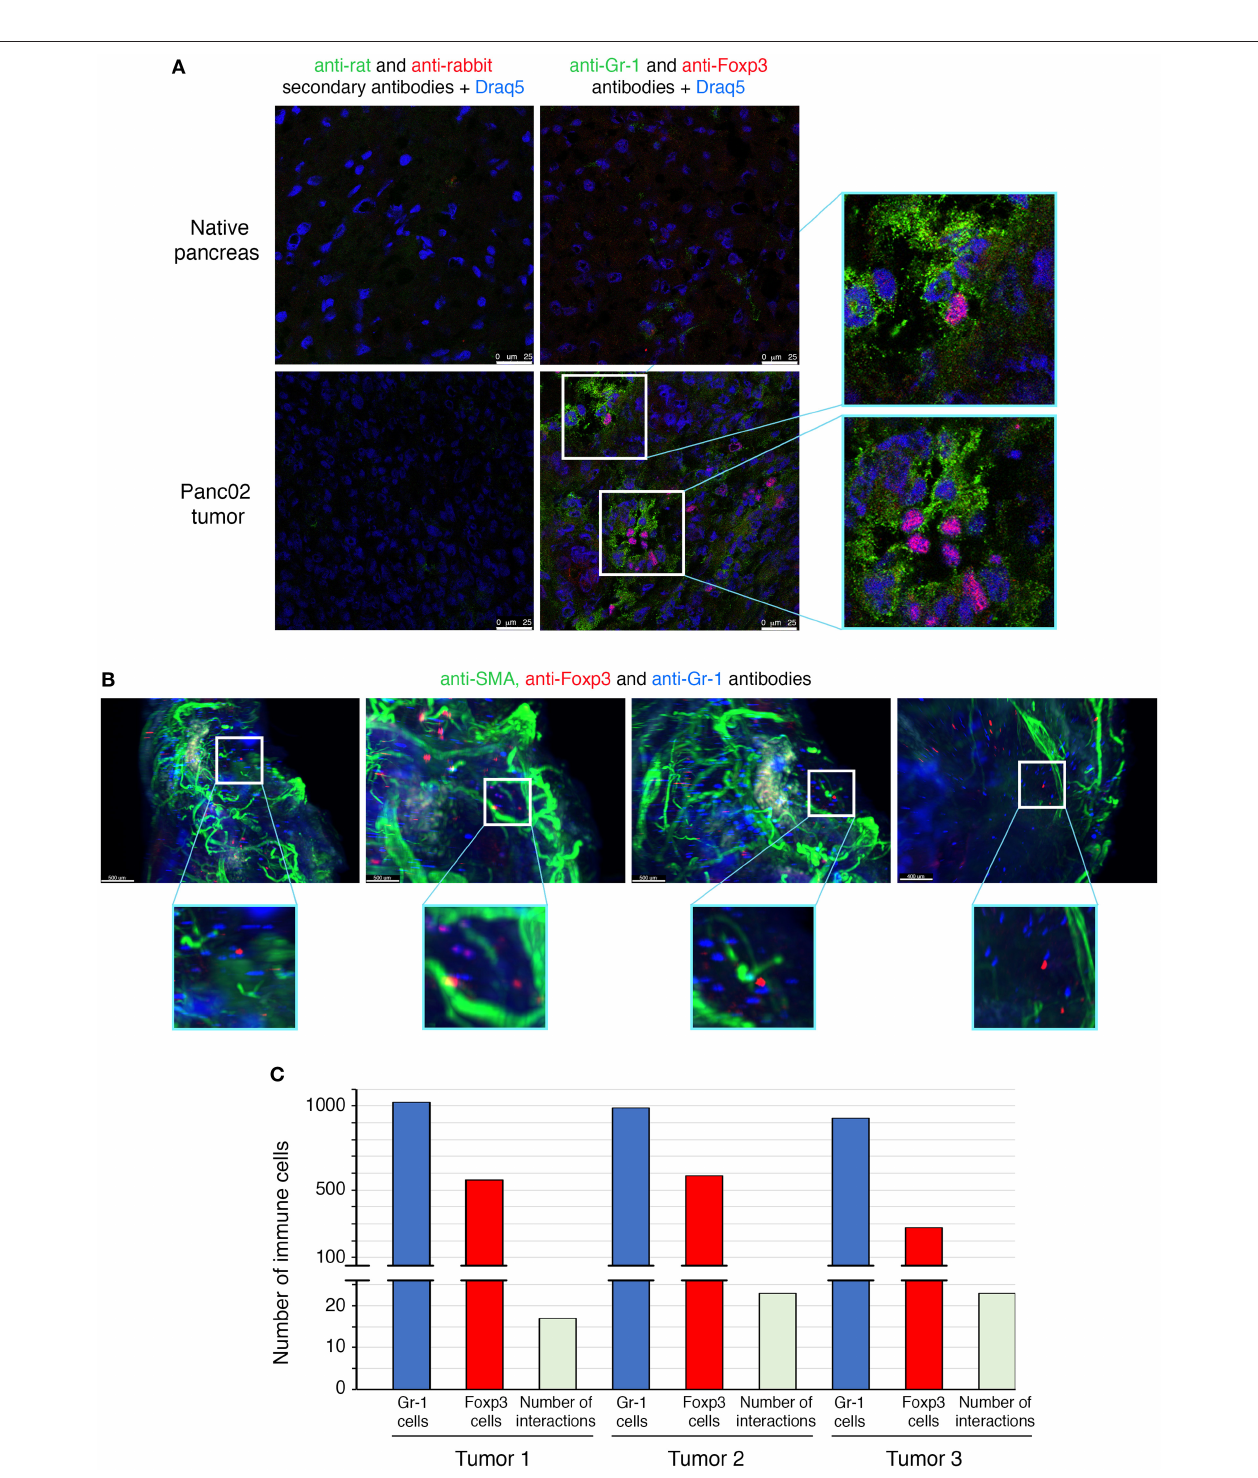
FIGURE 3 | Direct interactions between MDSCs and Treg cells in orthotopic mouse model of pancreatic cancer. Panc02 cells were injected in the pancreas of C57BL/6 mice and tumors were harvested 3 weeks post-inoculation. (A) Representative IHF (confocal microscopy) analysis of Gr-1 (MDSCs in green) and Foxp3 (Treg cells in red) on normal pancreas and on pancreatic tumor frozen sections. The nuclei (in blue) are stained with Draq5, a fluorescent DNA marker. Zooms show proximity between the different immune cells. Scale bar 25 µ m. (B) Light sheet microscopy analysis of Gr-1 (MDSCs in blue) and Foxp3 (Treg cells in red) on whole cleared pancreatic tumor. Zooms show closed contacts between the two populations. Blood vessels are stained with a pericyte marker, the alpha-smooth actin (in green). Scale bar 500 µ m. (C) Histogram represents quantification of interactions whole cleared tumors calculated with a matLab function associated with the Imaris software. See also Supplementary Figure 3 and Supplementary Videos 1–3